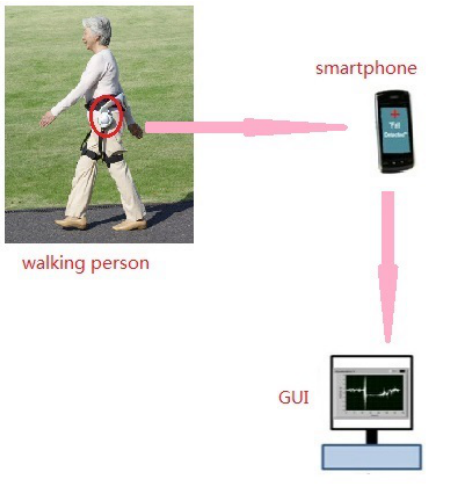
Figure 2: Gait monitor system diagram